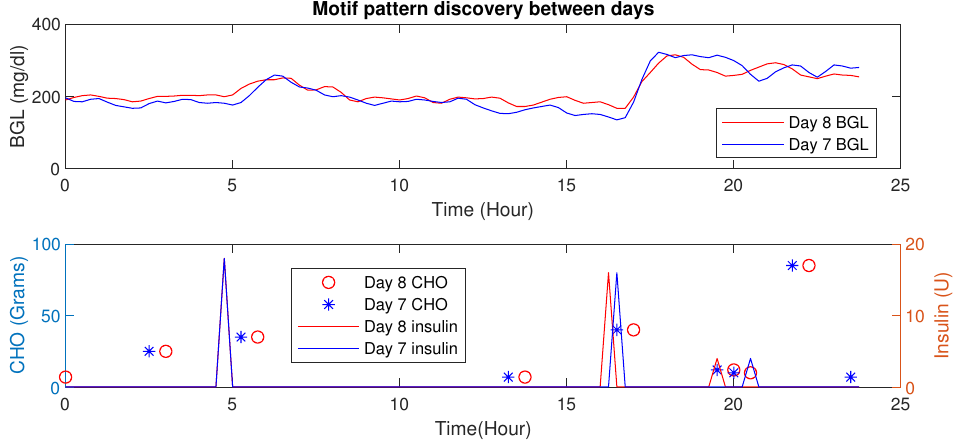
Figure 11. Time-Series Analysis: Motif Discovery between days of a P1. (Top) Dependent variable (BGL) versus time whereas the bottom show independent (controllable) behaviors (insulin) and CHO in food.